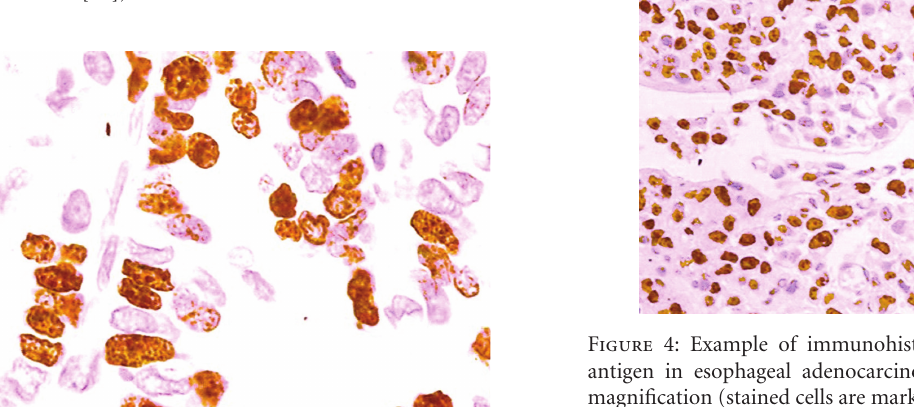
Figure 1: Ki-67 index: esophageal crypt scheme. Ki-67 index = (cid:2) / (cid:2) + (cid:3) × 100%, where closed circles represent marked nuclei. (Adapted from [44]).